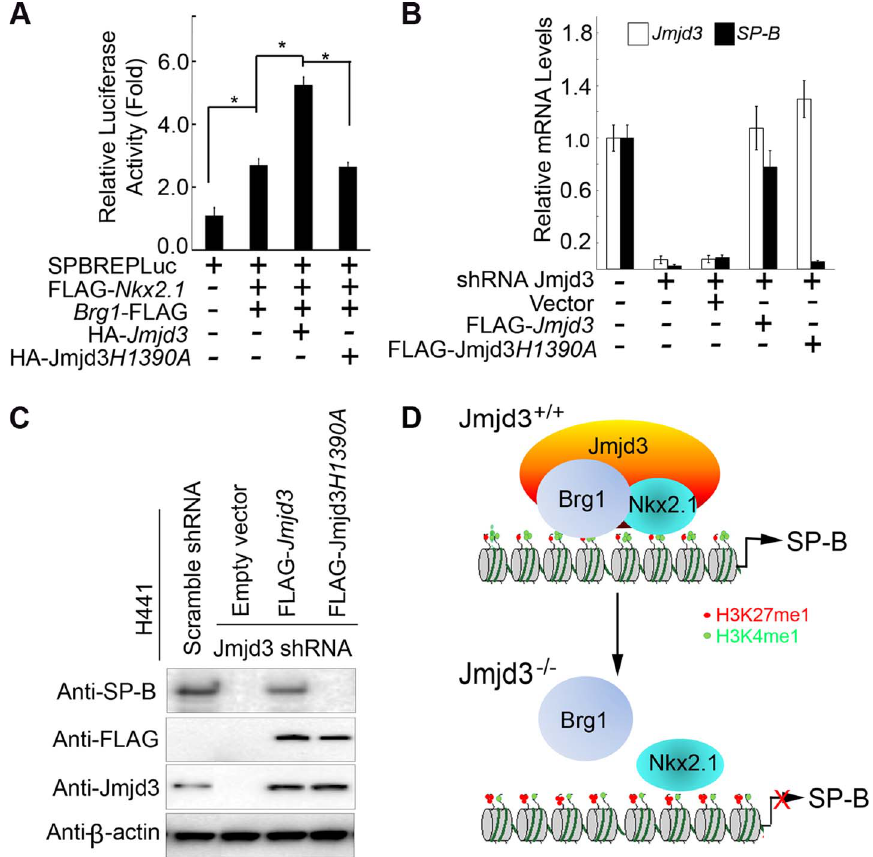
Figure 7. The demethylase activity of Jmjd3 is required for the regulation of SP-B expression. ( A ) WT, but not mutant, Jmjd3 enhanced NKx2.1 and Brg1-mediated SP-B promoter activity. Data are presented as the mean 6 SD from three independent experiments. * P , 0.05 (Student’s t test). ( B ) qPCR analysis of SP-B expression in Jmjd3-specific shRNA-expressing H441 cells transfected with WT or mutant Jmjd3 . Data are presented as the mean 6 SD from three independent experiments. ( C ) Immunoblot analysis of SP-B protein in Jmjd3-specific shRNA-expressing H441 cells transfected with WT or mutant Jmjd3 . ( D ) A proposed model explaining how Jmjd3 specifically upregulates SP-B expression by interacting with Nkx2.1 and Brg1 in the SP-B